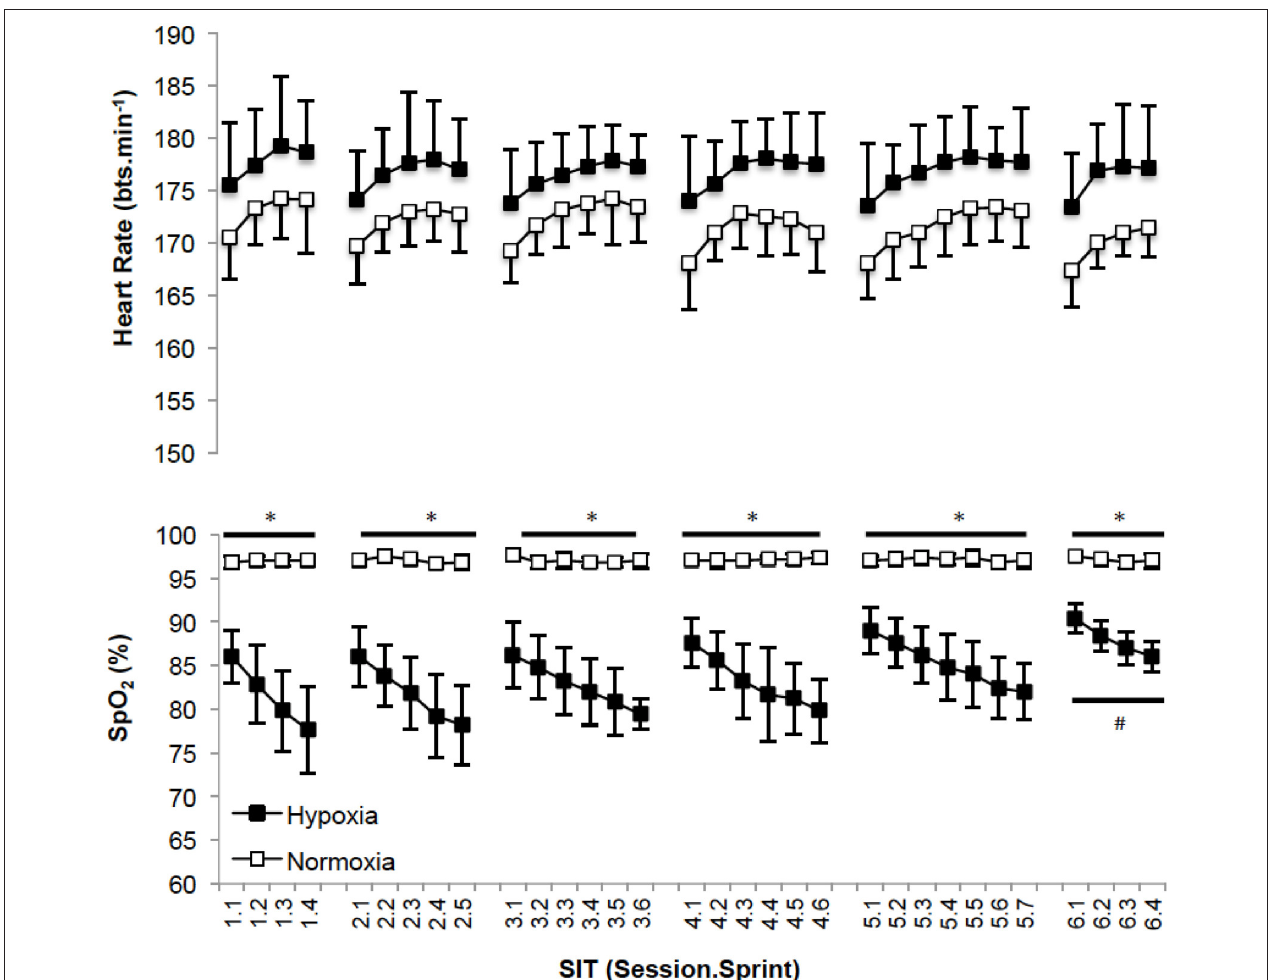
FIGURE 3 | (Mean ± SD ) SpO 2 and heart rate values after each sprint for all training sessions. *Denotes significant difference ( p < 0.05) between conditions within session. #Denotes significant difference ( p < 0.05) from first, second, third, fourth and fifth